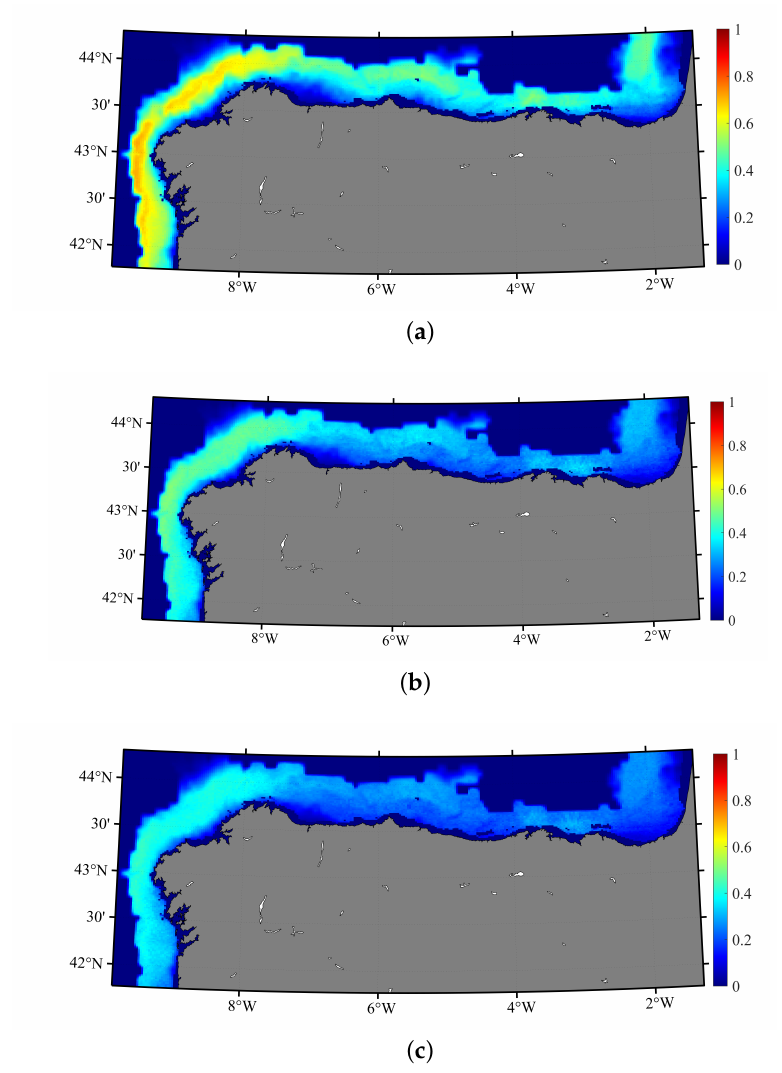
Figure 10. Risk-based variable results for each frequency band studied. ( a ) Corresponds to the 1 kHz case studied. This frequency should not be interpreted in terms of communication distance reduction between conspecifics, since the species of dolphin considered do not emit whistles at this frequency. However, it is included because it may be representative of the masking of other types of sounds present in the soundscape. The case of 5 kHz ( b ) and 10 kHz ( c ) can be interpreted in terms of communication distance reduction because at these frequencies bottlenose dolphins establish communication among them by means of whistles. It is possible to observe how the RBV is greater at 5 kHz due to the greater emission of noise from ships at this